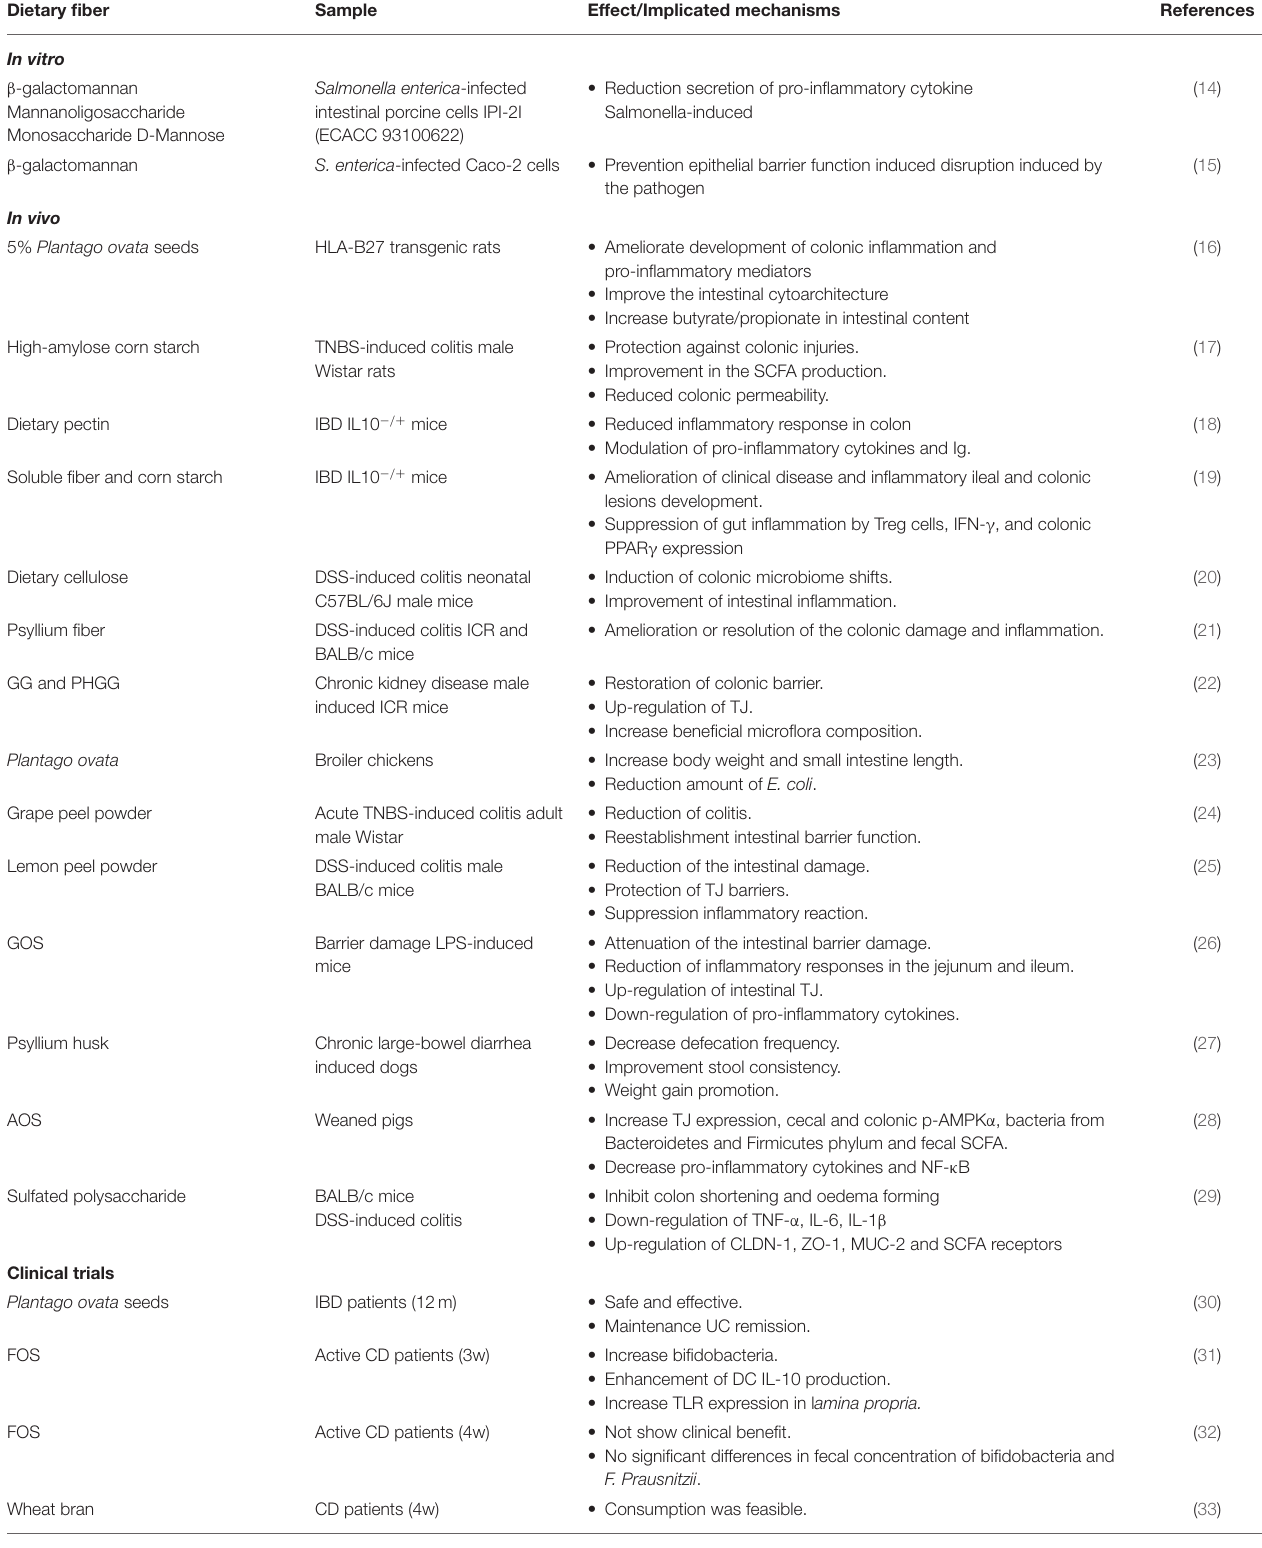
TABLE 1 | Dietary fiber role in the recovery of impaired barrier function. Dietary